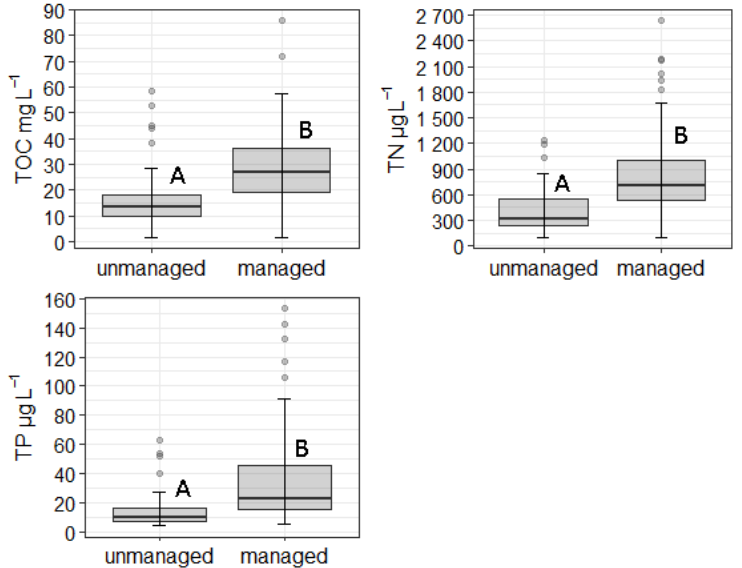
Figure 2. The flow-weighted TOC, TN and TP concentrations in runoff water in unmanaged and managed catchments during the monitoring period (2014–2018). The horizontal line in the box is the median. The boxes indicate the interquartile range while the whiskers show the largest and smallest value within 1.5 times interquartile range, with dots showing observations outside of these. The capital letters denote statistical differences, with different letters indicating a significant difference between unmanaged and managed.